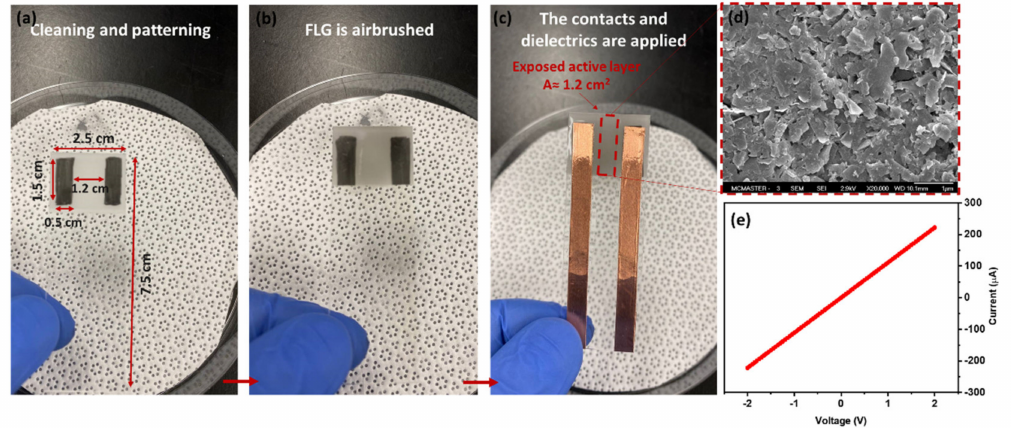
Figure 1. Sensor fabrication steps: ( a ) Cleaning and prepatterning with pencil-drawn contacts, ( b ) airbrushing FLG, and ( c ) attachment of Cu tape and dielectrics. ( d ) SEM image of the FLG airbrushed on the surface, ( e ) the I-V curve of the fabricated chemiresistive sensor indicating the ohmic device (sensor resistance was ∼ 10 k Ω